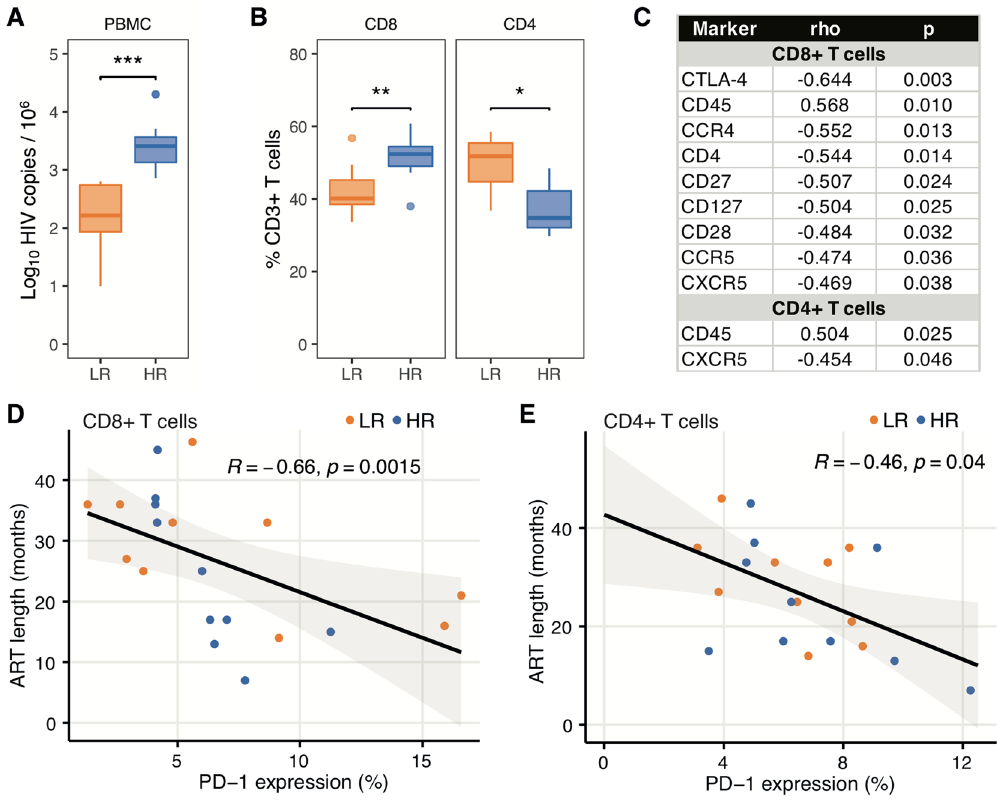
Figure 1. Number of HIV-1 DNA copies, frequencies of CD8 + and CD4 + T cells, and proteins correlating with the size of the HIV-1 reservoir and ART length in LR and HR patients. ( A ) Number of HIV-1 DNA copies in 10 6 PBMCs. ( B ) Frequencies of CD8 + and CD4 + T cells are shown. ( C ) Markers detected by CyTOF which correlate with the size of HIV-1 reservoir in the whole group of HIV-1 infected patients. ( D , E ) Correlation of ART length in LR and HR patients with frequencies of PD-1 + CD8 + and CD4 + T cells. Blood specimens from 10 HIV-1 infected patients with low HIV-1 reservoirs (LR) and 10 patients with high reservoirs (HR) were used. *p < 0.05, **p < 0.01, ***p <